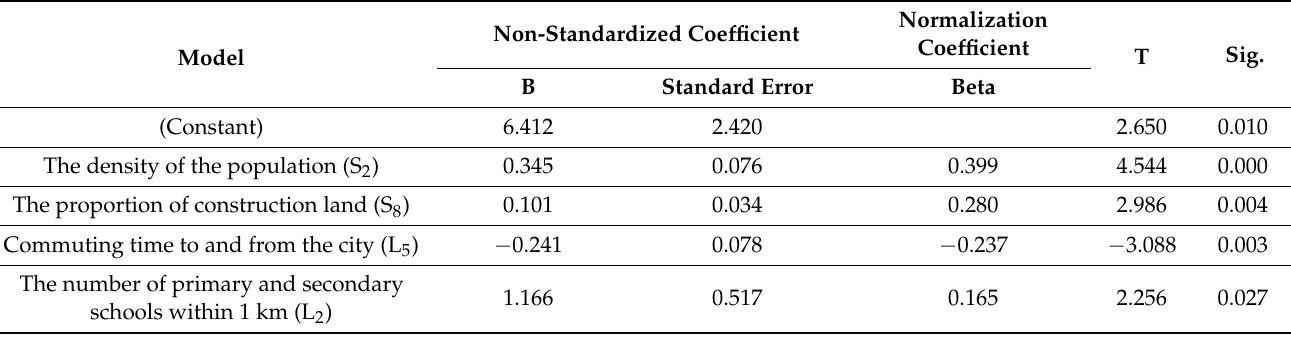
Figure 11. Multiple linear regression analysis between transit road density and practical factors of rural systemic risk (source: self-drawn). Table 5. The correlation coefficient between road density and risk factors based on multiple linear regression.